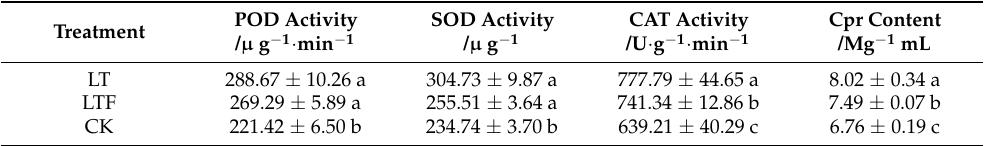
Table 2. Analysis of soluble protein content and antioxidase.